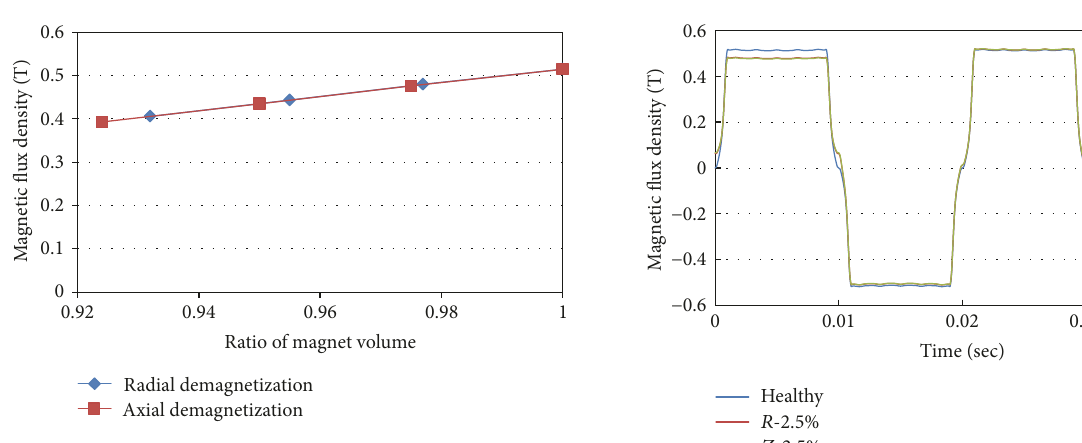
Figure 10: Calculated magnetic flux density at the center point of air-gap and 𝜃 = 315 ∘ for ratio of PM volume. Figure 11: Calculated magnetic flux density waveform at the stator